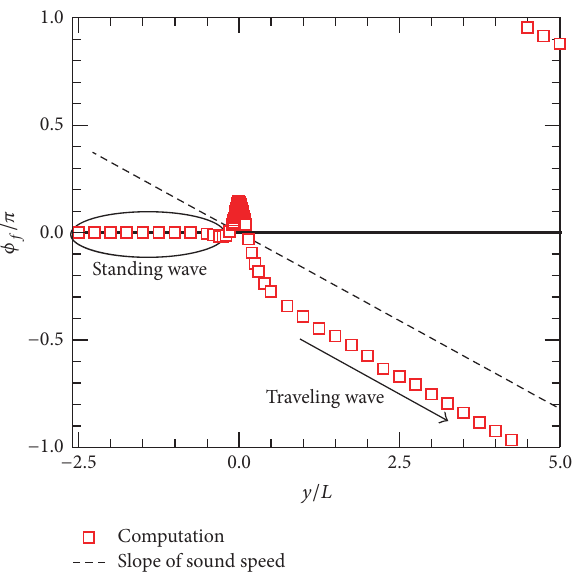
Figure 11: Predicted phase differences of pressure fluctuations, 𝐶 𝑝 ≡ 𝑈 ∞2 , at fundamental frequency vertically along 𝑥/𝐿 = 0.5 𝑝/0.5𝜌 ∞ for cavity flow with acoustic resonance (𝐷/𝐿 = 2.5)